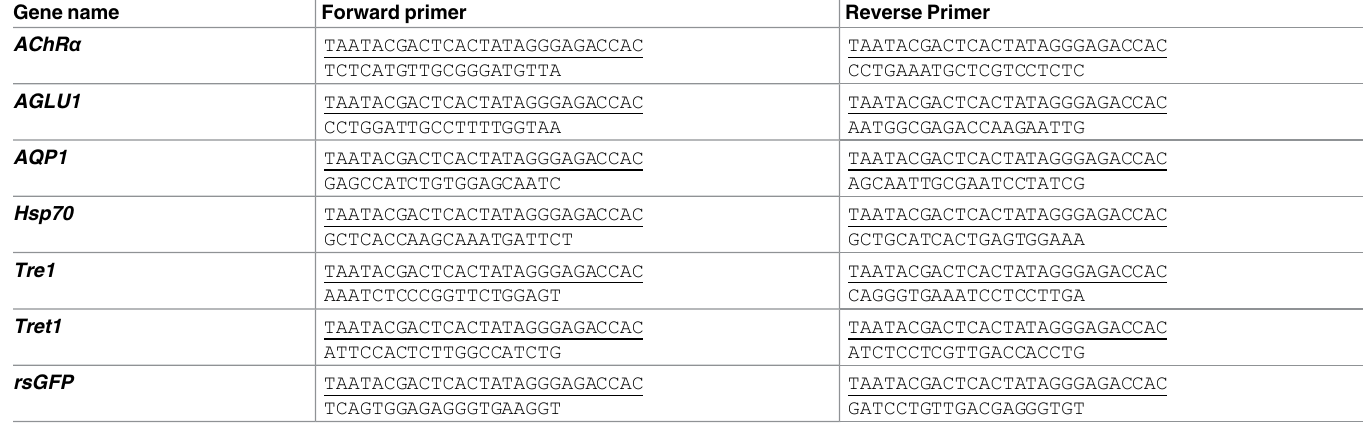
Table 1. Primers used for PCR and RT-PCR amplification and in vitro transcription. The T7 promoter sequenceis